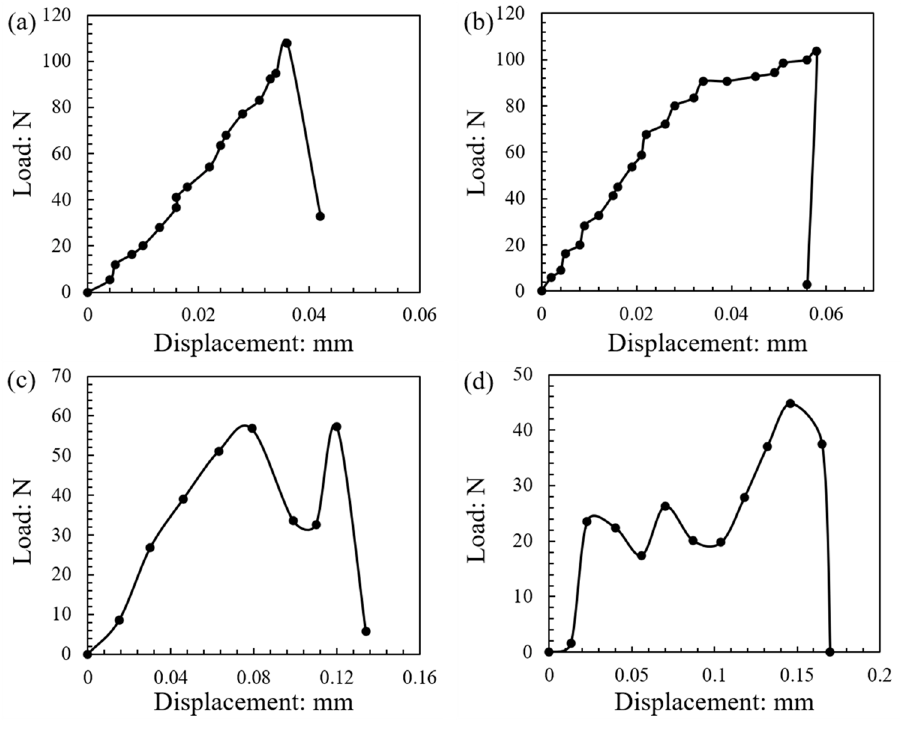
Figure 19. Different classes (types) of load–displacement curves: ( a ) class-A; ( b ) class-B; ( c ) class-C; ( d ) class-D.